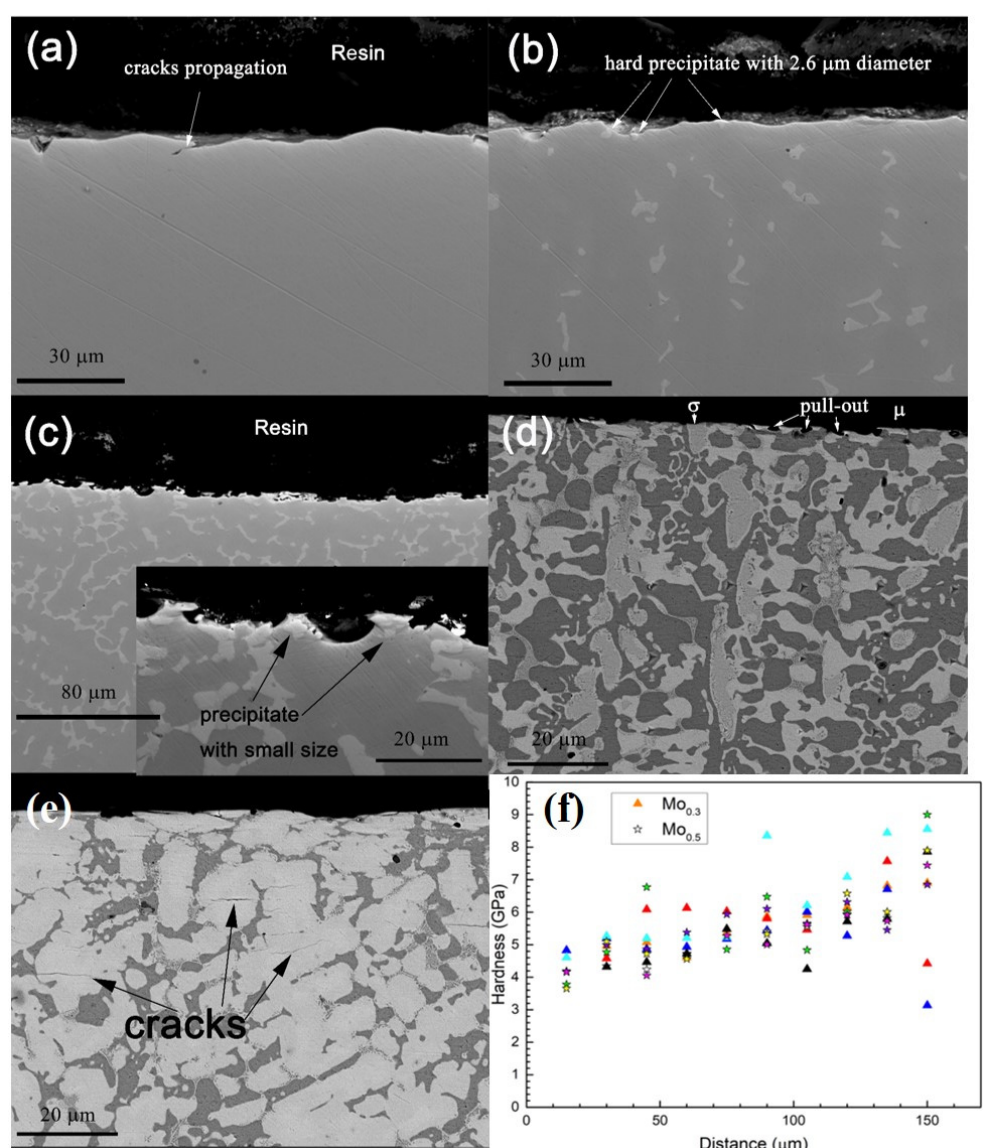
Figure 13. The SEM images of the cross-sections of the wear tracks on high entropy alloys (HEAs), and the work-hardening behavior of the Mo0.3 and Mo0.5 FCC solid solution, ( a ) for Mo0 alloy, ( b ) for Mo0.3 alloy, ( c ) for Mo0.5 alloy, ( d ) for Mo1 alloy, ( e ) for Mo1.5 alloy, ( f ) is the hardness of Mo0.3 and Mo0.5 alloy.